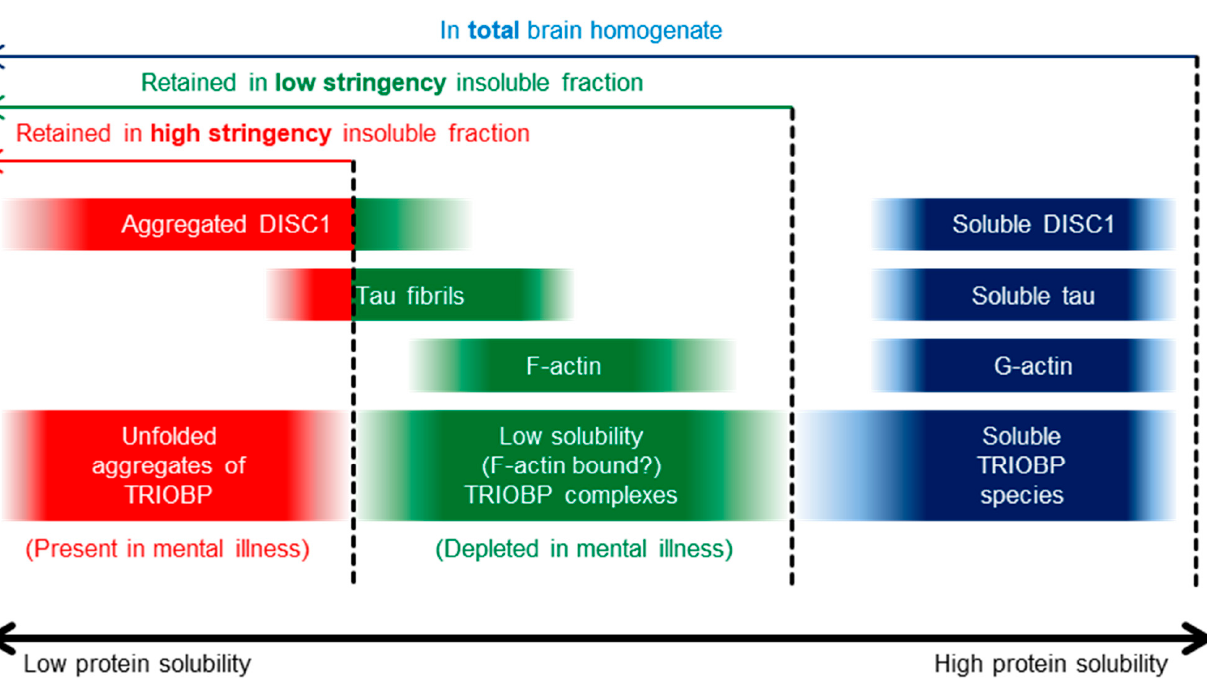
Figure 7. Representation of different species of TRIOBP-1, DISC1, Tau and actin described in the brain, arranged by solubility. Total brain homogenate contains all of these species, while the insoluble fractions derived from the low and high stringency purification protocols described here include only increasingly smaller subsets of insoluble protein.